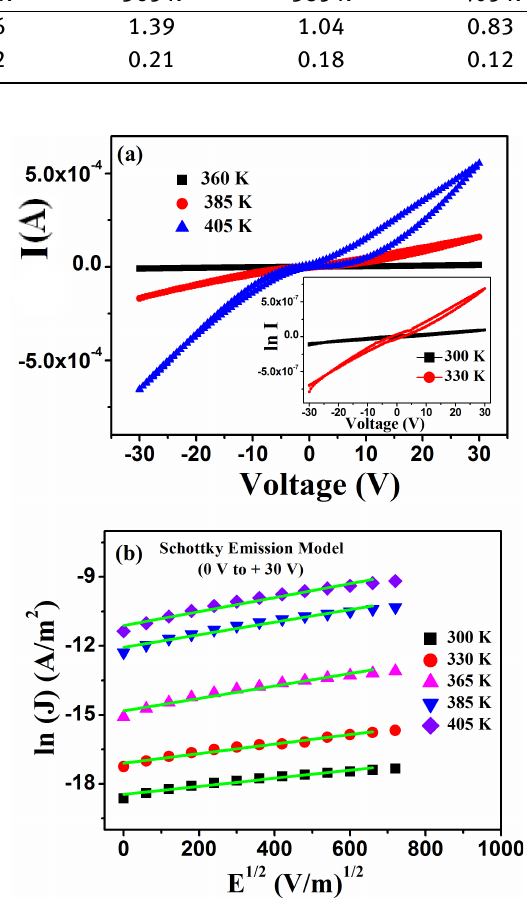
Table 4: Junction barrier height, dynamic dielectric constant of the sample from current-voltage characteristics study. Derived electrical parameters